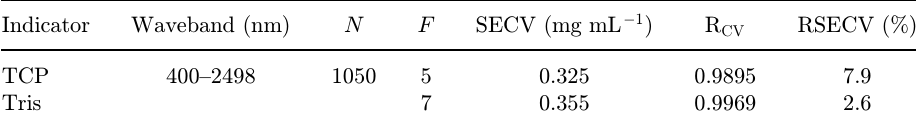
Table 2. Parameter selection and prediction e®ects of the full PLS models for TCP and Tris. Indicator